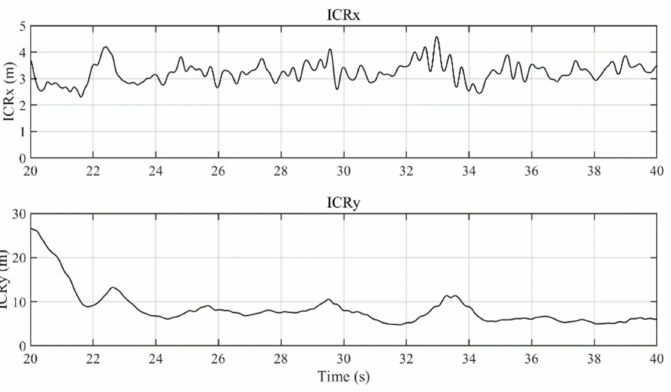
Figure 13. The instantaneous center of rotations (ICRs) of the vehicle when the vehicle turns.